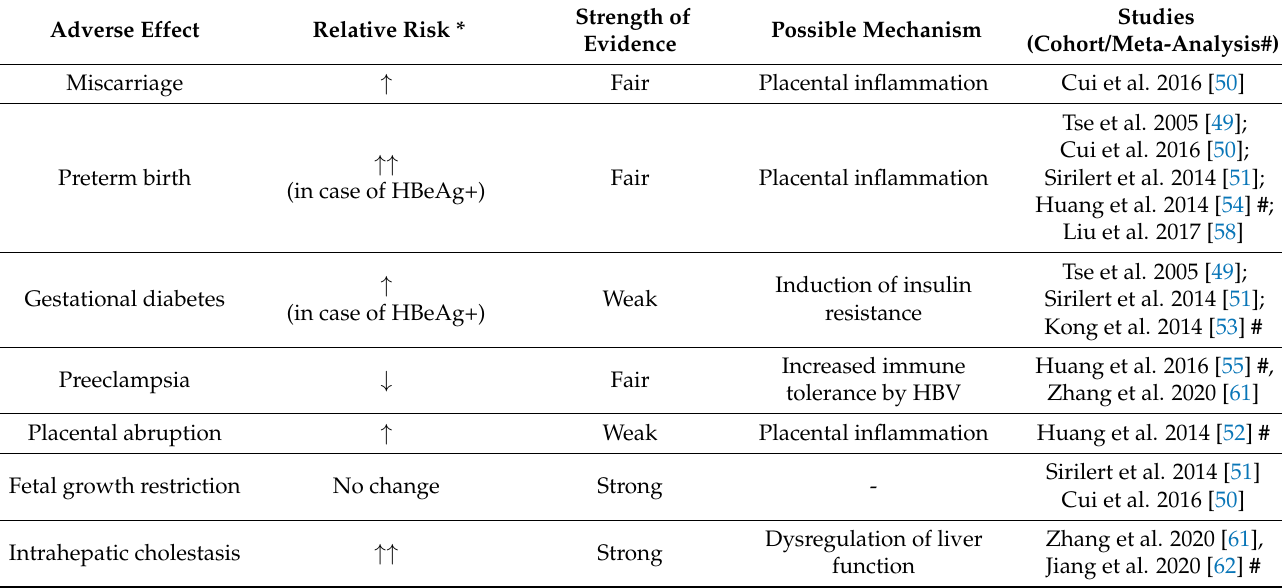
Table 2. Possible adverse pregnancy outcomes associated with HBV